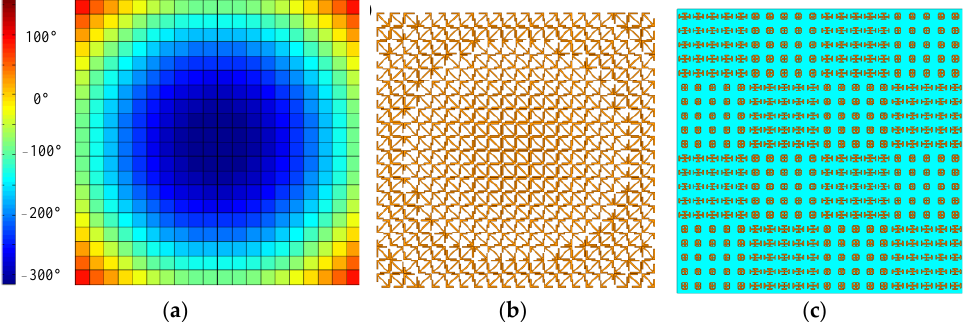
Figure 10. Structure diagram of metasurface transmission array: ( a ) phase distribution; ( b ) metal arrow corresponding to different phase; ( c ) checkerboard distribution.